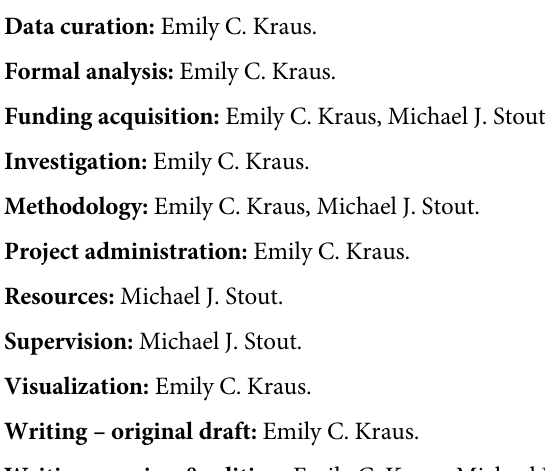
S1 Table. Dates of agricultural practices. Dates of agricultural practices including seed treat- ments, water seeding, flooding, and foliar sprays. Sample dates for emergence, biomass, rice water weevil core samples, heading, and harvest. S2 Table. Supplemental data. Mean and standard error are provided for each treatment, on each sample date, for all response variables in experiments in 2017 and